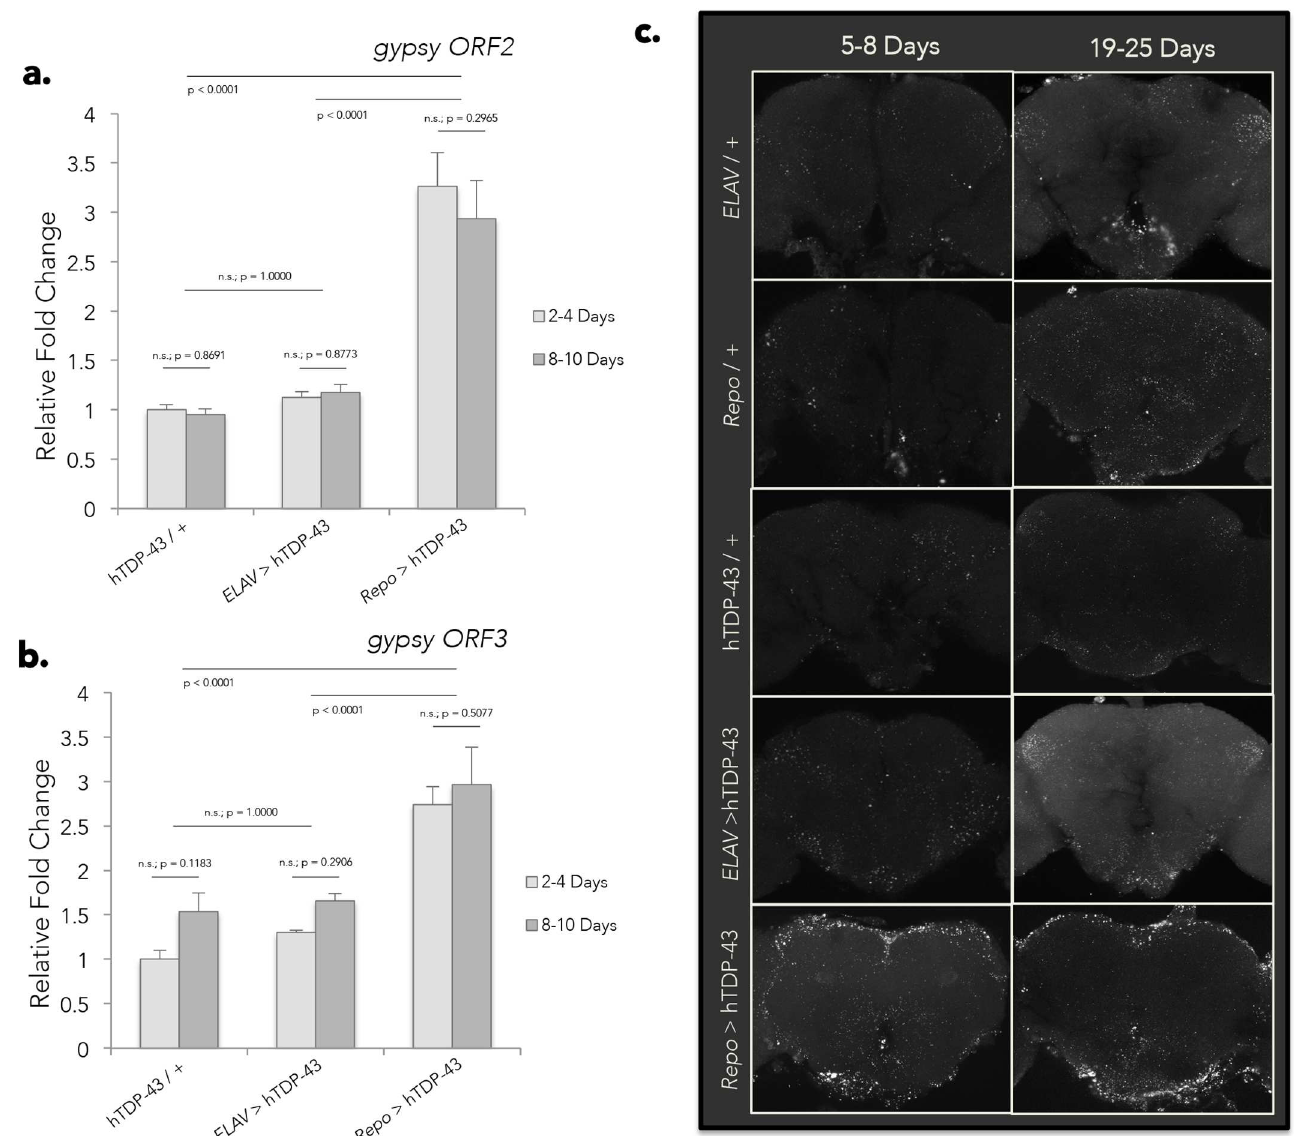
Fig 2. Glial hTDP-43 expression results in early and dramatic de-suppression of the gypsy ERV. (A) Transcript levels of gypsy ORF2 ( Pol ) as detected by qPCR in wholehead tissue of flies expressinghTDP-43 in neurons( ELAV > hTDP-43) versus glia ( Repo > hTDP-43) at a young (2–4 Day) or aged(8–10 Day) time point. Transcript levels normalizedto Actin and displayedas fold changerelative to flies carrying the hTDP-43 transgenewith no Gal4 driver (hTDP-43 / +) at 2–4 Days (means + SEM). A two-way ANOVA reveals a significanteffect of genotype(p < 0.0001)but no effect of age (p = 0.5414). N = 8 for all groups. (B) An equivalentanalysisshows that gypsy ORF3 ( Env ) likewisedisplaysa significanteffect of genotype(p < 0.0001) and no effect of age (p = 0.6530). N = 4 for the 2–4 Day cohort and N = 5 for the 8–10 Day cohort. (C) Centralprojectionsof whole mount brains immunostained with a monoclonal antibody directedagainst gypsy ENV protein reveals dramatic, early accumulationof ENV immunoreactive puncta in brains expressingglial hTDP-43 (5–8 Days) in comparisonto both age-matched genetic controls ( ELAV / +; Repo / +; hTDP-43 / +) and flies expressing neuronalhTDP-43. This effect persists out to 19–25 Days post-eclosion. ELAV / +, 5–8 Day ( N = 3), 19–25 Day ( N = 4); Repo / +, 5–8 Day ( N = 3), 19–25 Day ( N = 3); hTDP-43 / +, 5–8 Day ( N = 5), 19–25 Day ( N = 2); ELAV > hTDP-43, 5–8 Day ( N = 2), 19–25 Day ( N = 4); Repo > hTDP-43, 5–8 Day ( N = 7), 19–25 Day ( N =